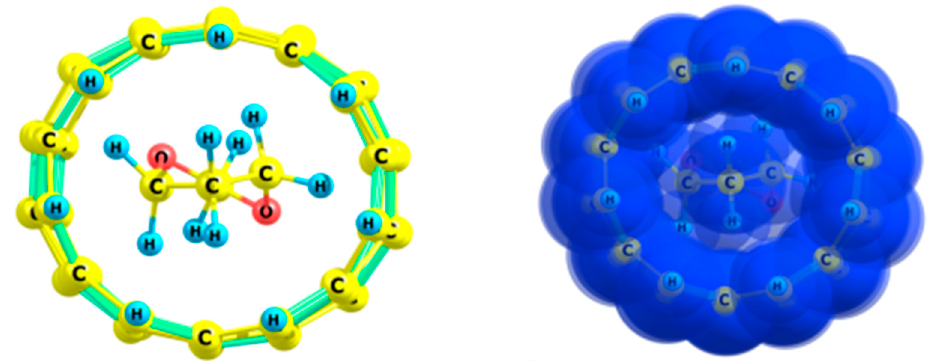
Figure 16. Cluster C 4 H 8 O 2 @(7,0). Adapted with modification [213].